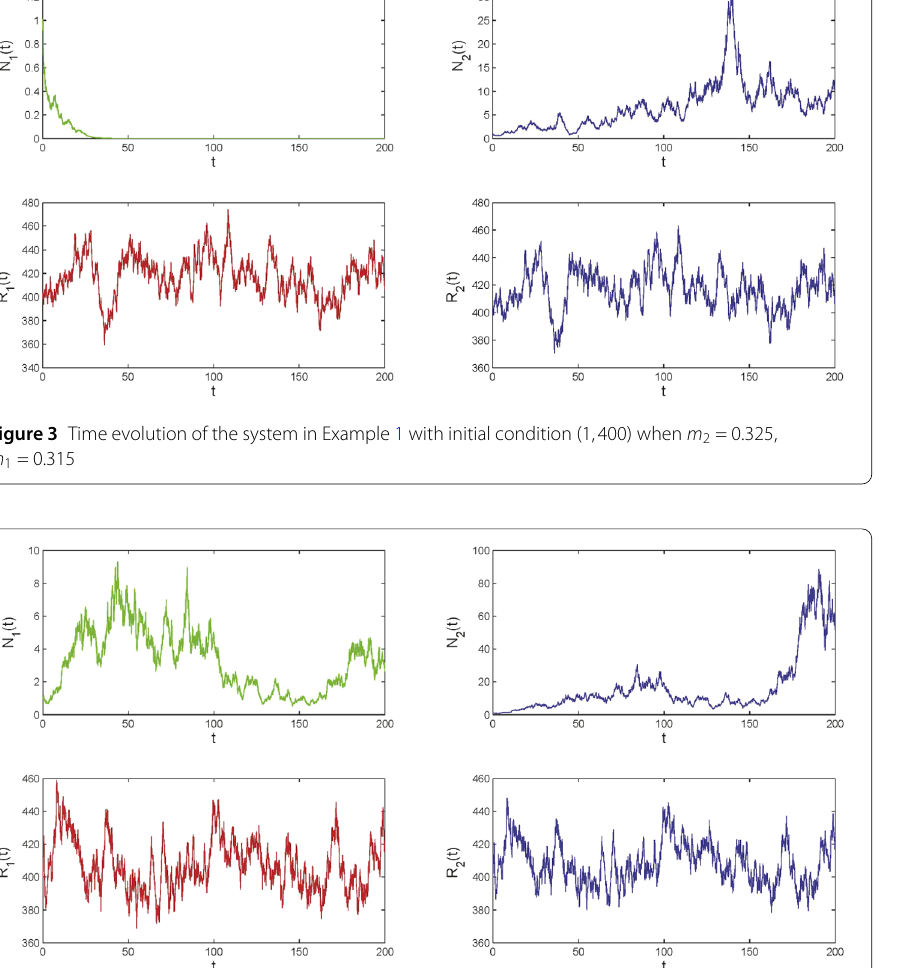
Figure 4 Time evolution of the system in Example 1 with initial condition (1,400) when m 1 = 0.5, m 2 =